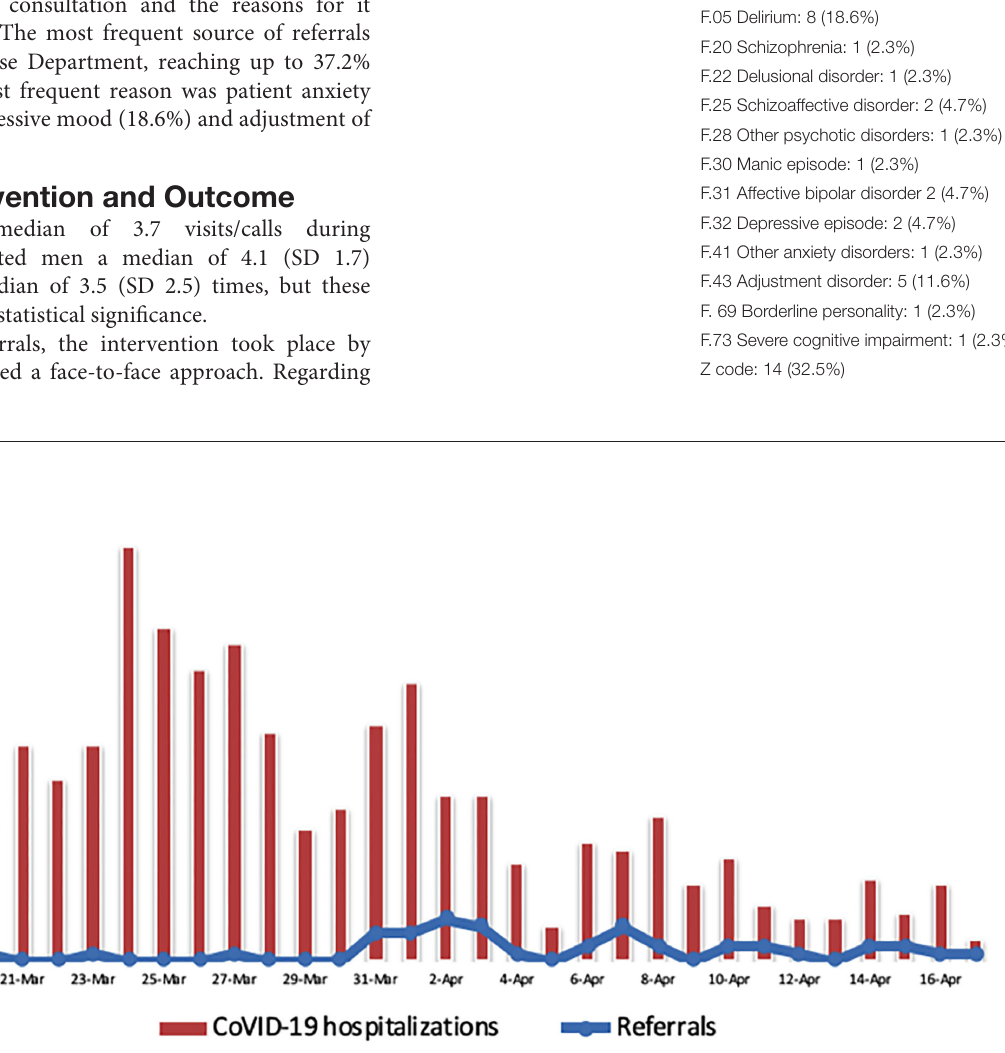
FIGURE 1 | Total daily hospitalized SARS-CoV-2 infections are depicted in vertical red charts. The blue line represents the evolution of daily psychiatry liaison referrals.